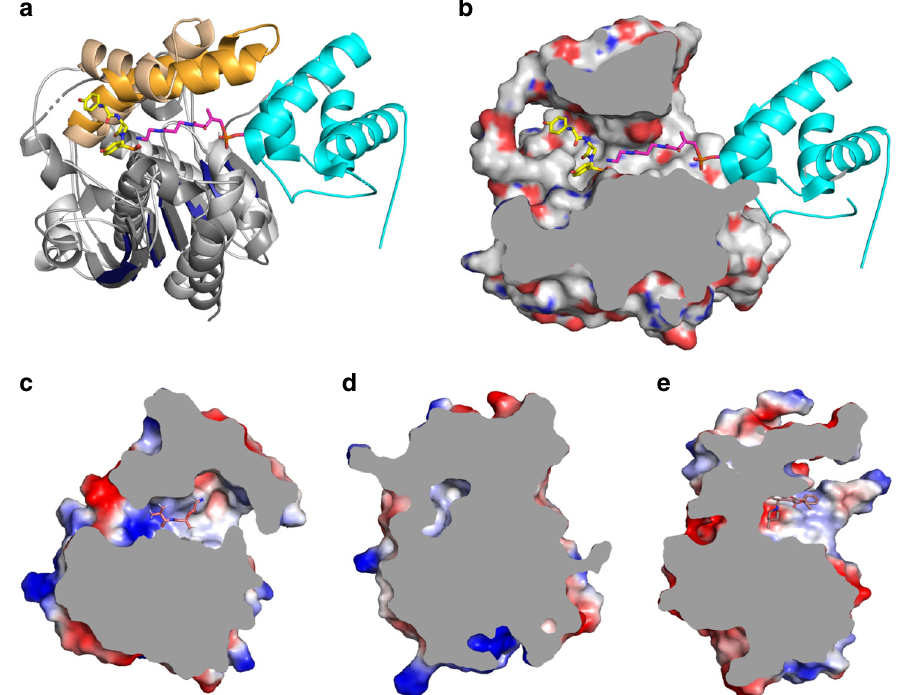
Fig. 6 Ligand binding pockets of NocTE and other TE domains. a Superposition of the EntF PCP-TE di-domain (PDB 3TEJ) on NocTE. The core N-terminal α / β hydrolase fold is colored gray and deep blue, lid helices in orange and wheat respectively. The EntF PCP domain is colored cyan and pantetheine arm in magenta. The pantetheine atoms derived from the 3TEJ, substrate analog are shown in magenta. The pantetheine terminates in a nitrogen derived from the amide analog used in this study. The NocTE inhibitor is in yellow, blue and red elemental colors. b Superposition of EntF PCP-TE di-domain on NocTE showing PCP-docking site and pantetheine tunnel in NocTE electrostatic surface representation. c Channel open at two-ends in TE domain in Vlm2 (6ECE). d Closed channel with a cavity at catalytic site in PksA TE domain (3ILS). e One-end open channel in Pks13 TE domain (5V3X)